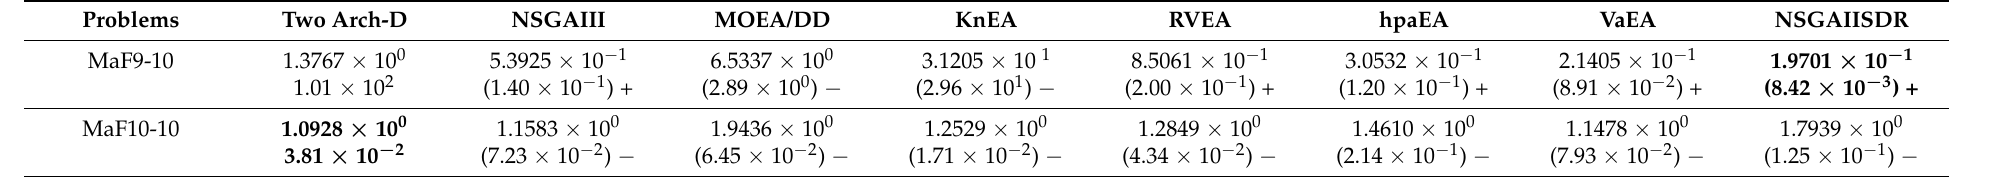
Table 2. IGD mean and standard deviation values of each